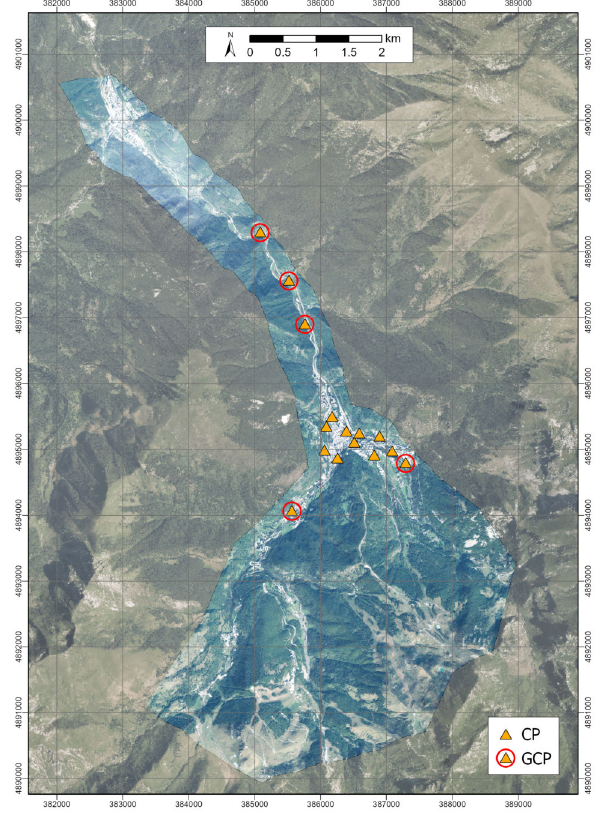
Figure 6. Spatial distribution of CP and GCP overlapped to the satellite